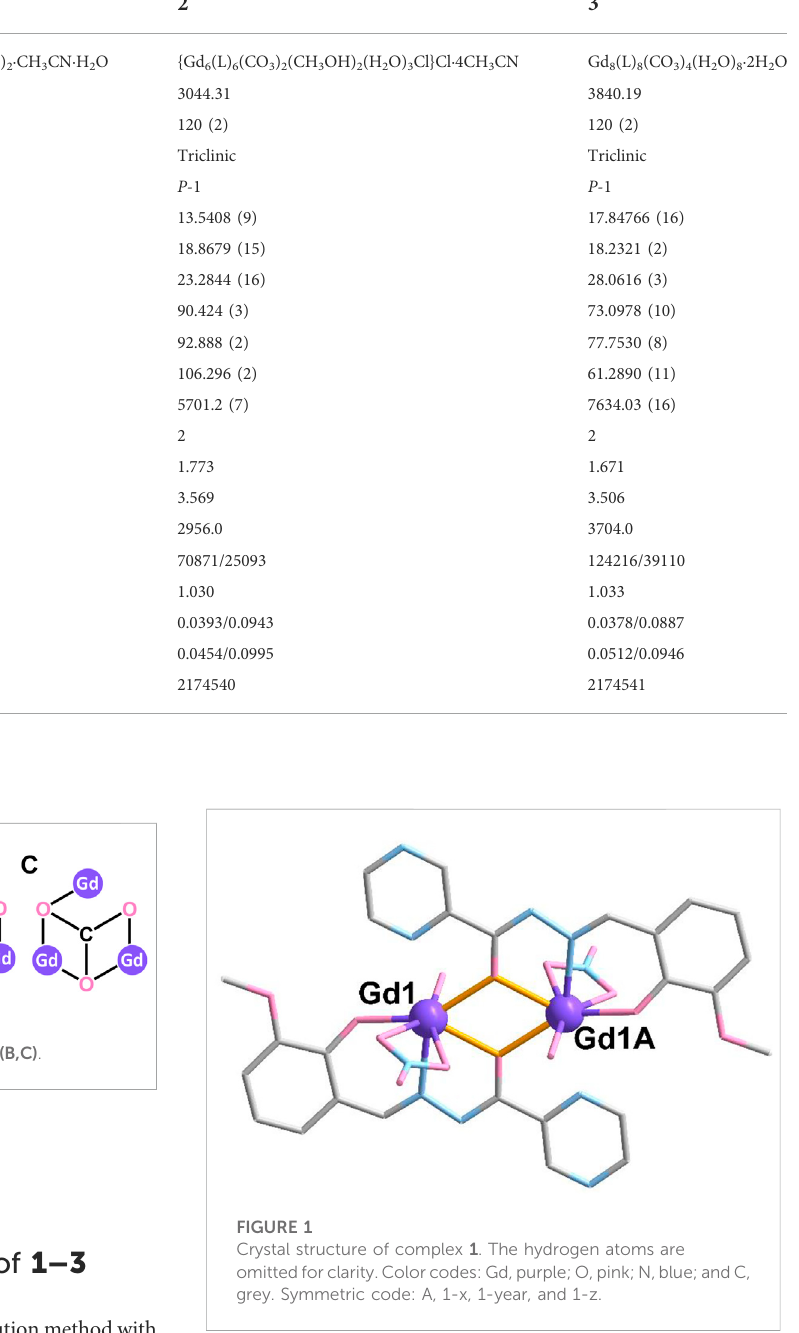
TABLE 1 Crystallographic data and structural re fi nement parameters for complexes 1 – 3. Complex